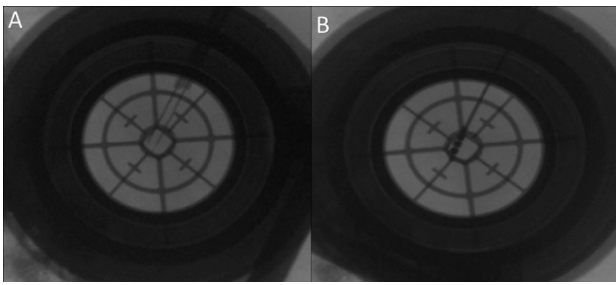
Figure 8. Fluoroscopic confirmation of the electrode position showing ( A ) a second microelectrode is inserted posterior to the original one due to suboptimal subthalamic nucleus (STN) signal during mapping along the original trajectory; ( B ) the final position of the deep brain stimulation (DBS) electrode in the new posterior trajectory.